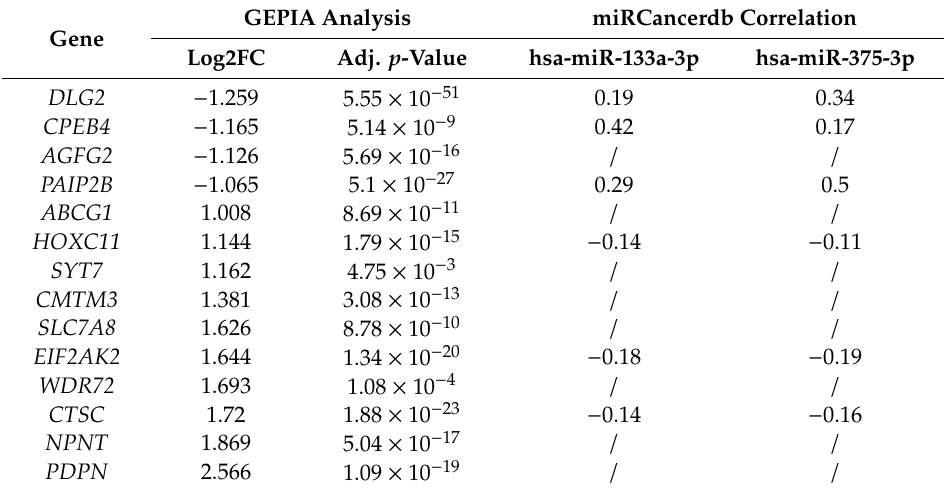
Table 2. Dysregulation and correlation levels of genes targeted by hsa-miR-133a-3p and hsa-miR-375-3p according to TCGA HNSC